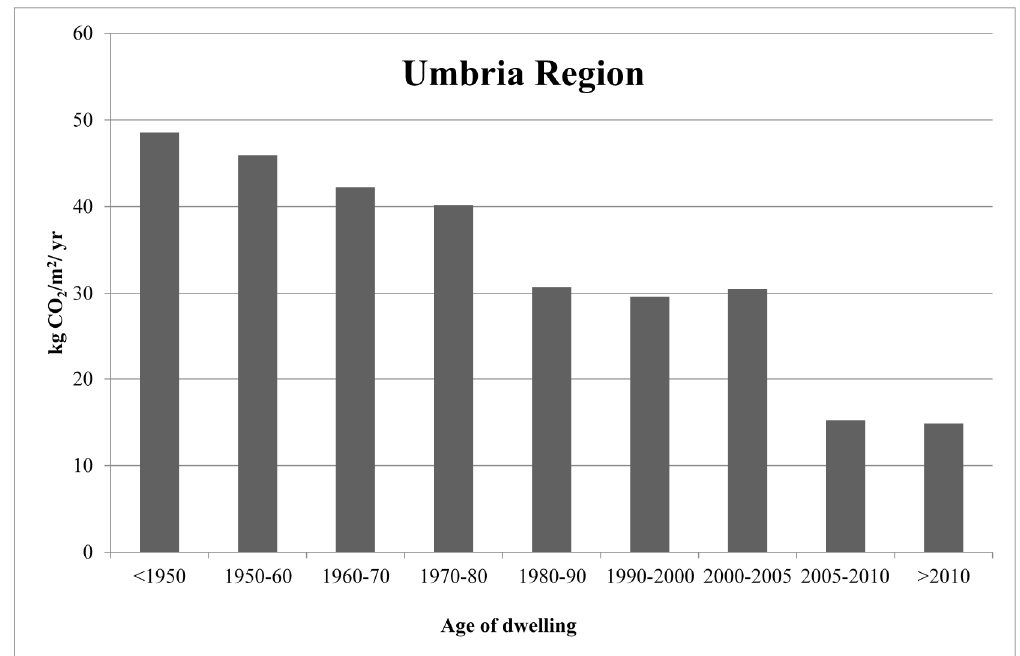
Figure 7. Annual average CO 2 emissions per unit of floor area (m 2 ) as a function of the age of dwelling (not climate corrected) in Umbria.